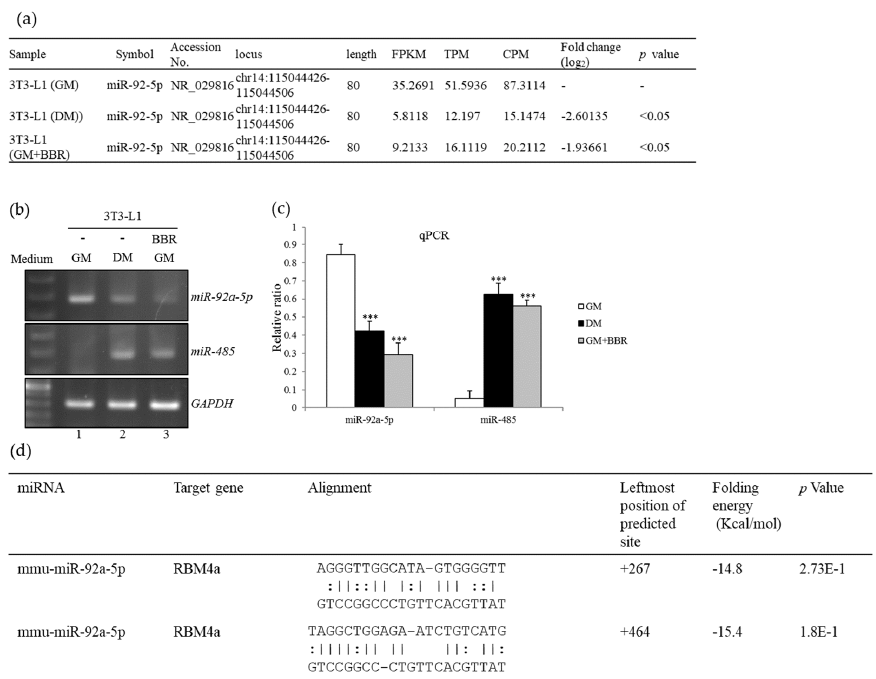
Figure 3. Berberine treatment reprogram expression profiles of miRNAs. ( a ) Results of miRNA-seq assays were analyzed using the CLC genomics workbench (CLC, GWB). Analytical results showed